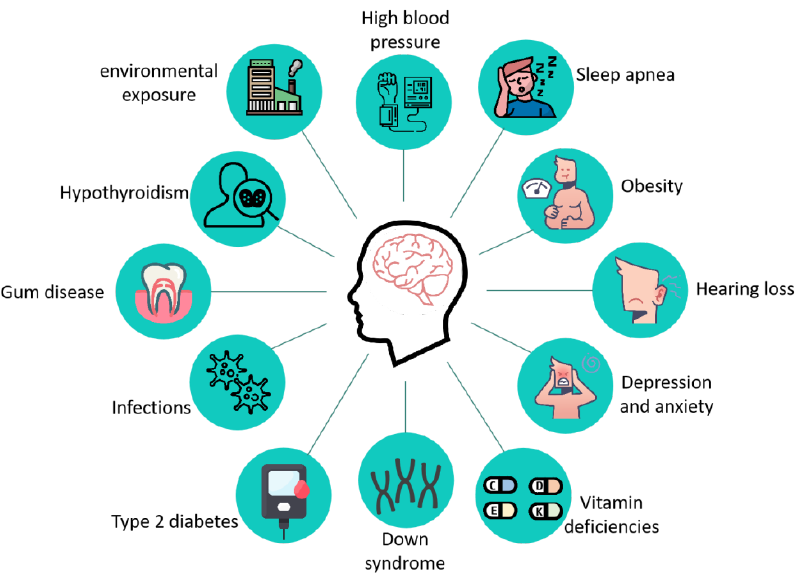
Figure 1. Related diseases that increase the risk of developing AD. Twelve diseases associated with AD have been reported: high blood pressure, sleep apnea, obesity, hearing loss, depression and anxiety, vitamin deficiencies, down syndrome, type 2 diabetes, infections, gum disease, hypothyroidism, and environmental exposure.